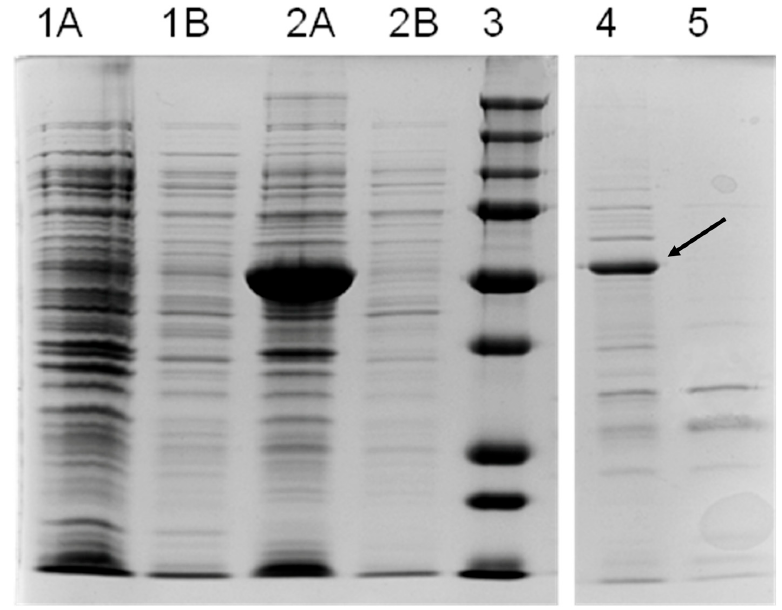
Figure 2. SDS-PAGE of crude extracts and purified preparation of E. coli expressing the Oe AAS gene. Lanes 1: Crude extract of E coli, with empty pET-28a (+) vector as control, pellet fraction ( 1A ), and soluble fraction ( 1B ); Lanes 2: Crude extract of transformed E. coli with the OeAAS construct, pellet fraction ( 2A ), and soluble fraction ( 2B ); Lane 3: Molecular mass markers; Lane 4: Recombinant OeAAS purified preparation (7 µg total protein). The arrow indicates the recombinant protein with a calculated MW of 54 kDa; Lane 5: Purified protein preparation from control E. coli (7 µg).